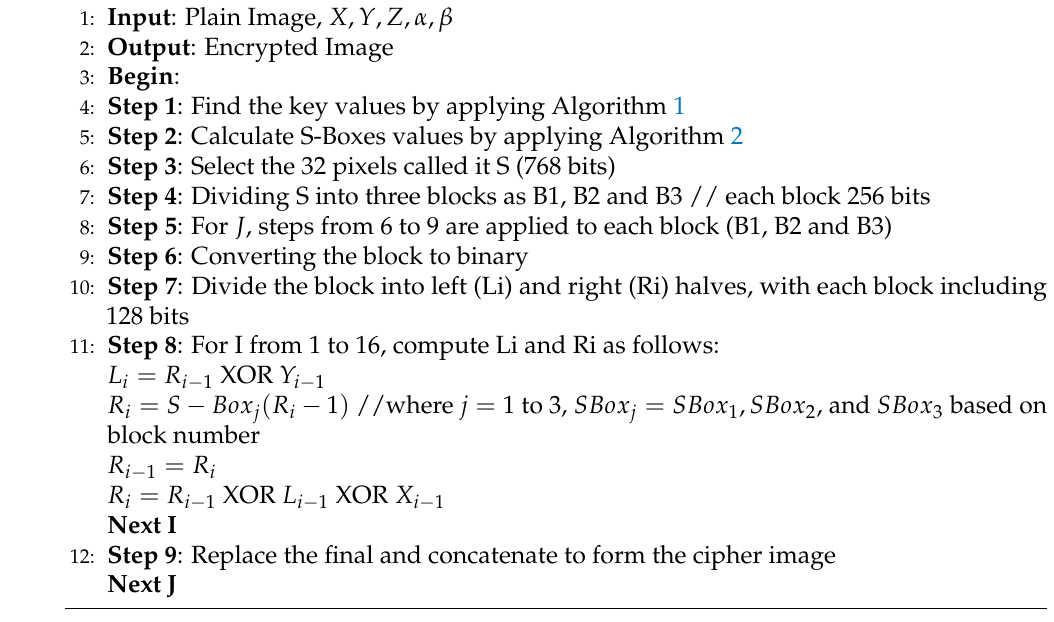
Algorithm 3 Enhanced CAST encryption